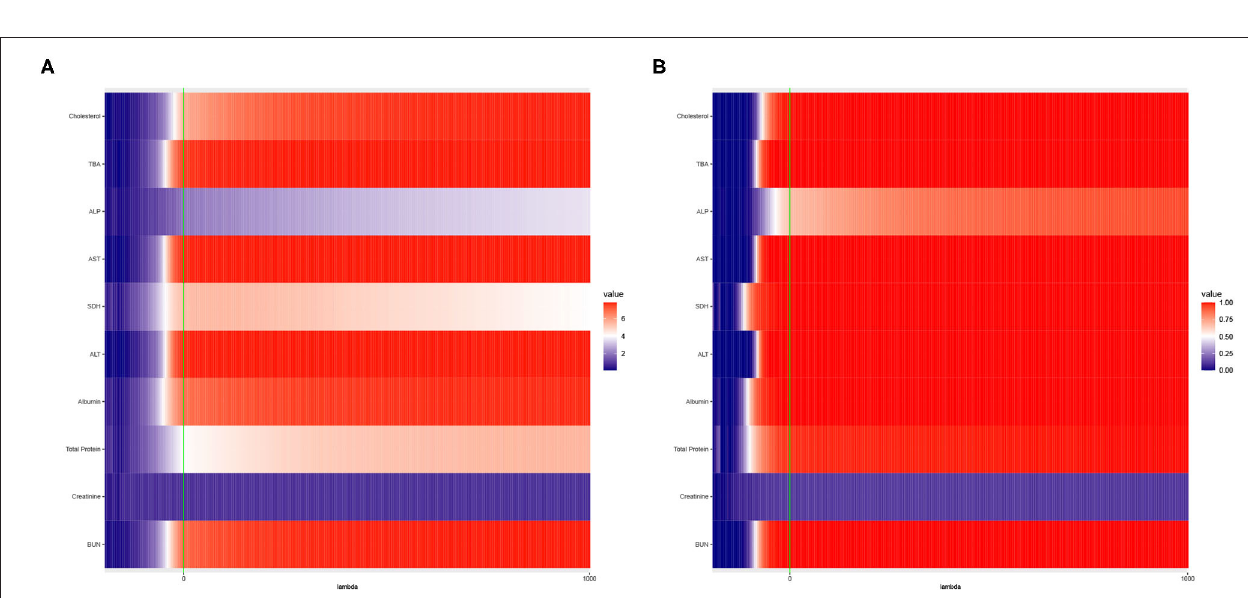
FIGURE 2 | Heat maps of (A) Average of − log 10 p -values and (B) Empirical Power of the Adaptive Mantel test using the liver toxicity data with n = 64 observations, p = 3,116 genetic features. The green vertical line corresponds to λ = 0.